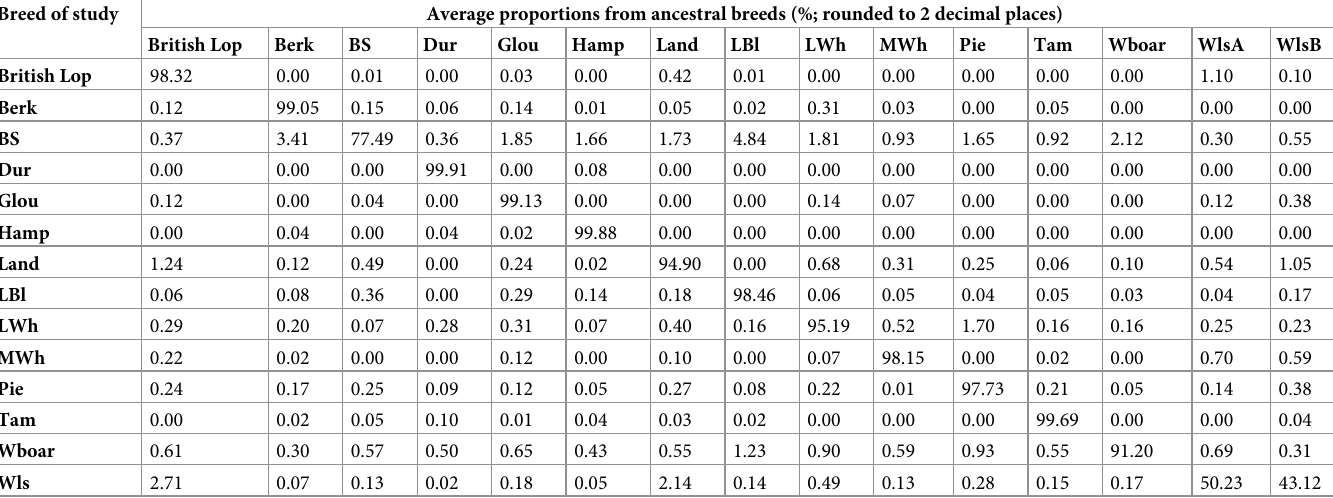
Table 2. Average admixture in the British Lop and other pig populations (unsupervised admixture analysis). Breed of study Average proportions from ancestral breeds (%; rounded to 2 decimal places) British Lop Berk Dur Hamp 0.00 Land LBl 0.06